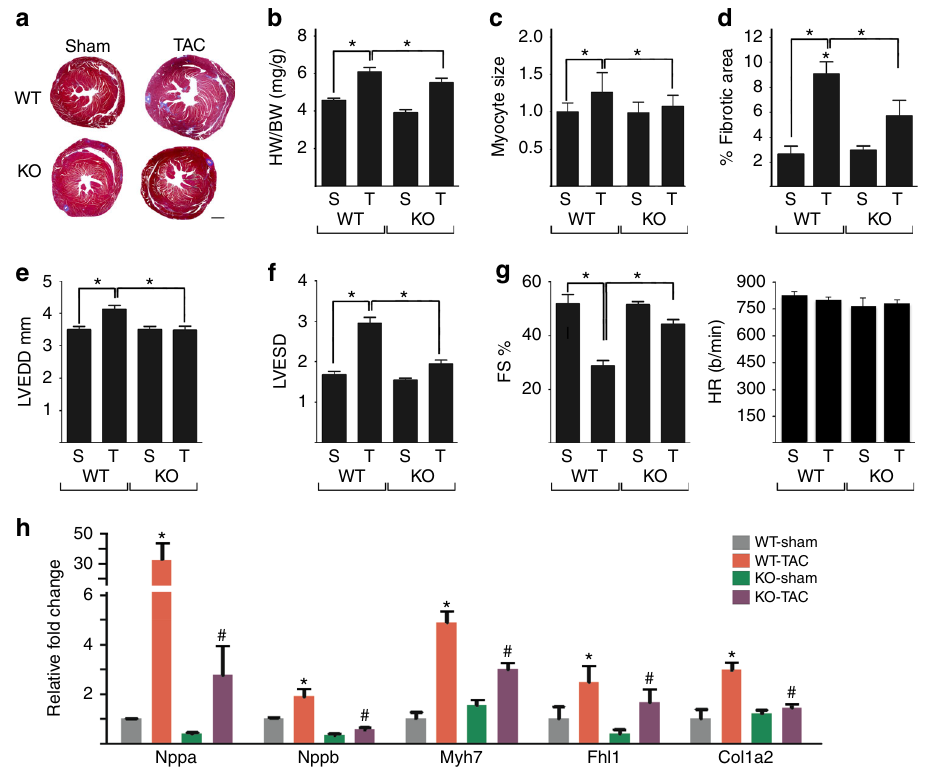
Fig. 3 Kdm3a -de fi ciency protects mice again TAC-induced hypertrophic remodeling. WT and Kdm3a KO (KO) mice were subjected to Sham and TAC surgery. Hearts were echoed and harvested 6 weeks post-surgery for histological and biochemical analysis. a H&E staining of histologic sections of WT and KO mouse hearts. Scale bar, 1 mm. b HW/BW, c relative myocyte size, and d percent of fi brotic area of WT and KO mouse hearts. e LVEDD, f LVESD, g percent FS and heart rate of WT and KO mouse hearts. h Relative mRNA of canonical fetal gene markers (Nppa, Nppb, and Myh7), Fhl1, and Col1a2. mRNA transcripts were measured by qRT-PCR, normalized against internal Gapdh, and expressed relative to Sham WT mice. n = 6-10 ± SEM. * , # p < 0.05 (ANOVA). *, WT TAC vs. WT Sham. # , Tg-TAC vs.